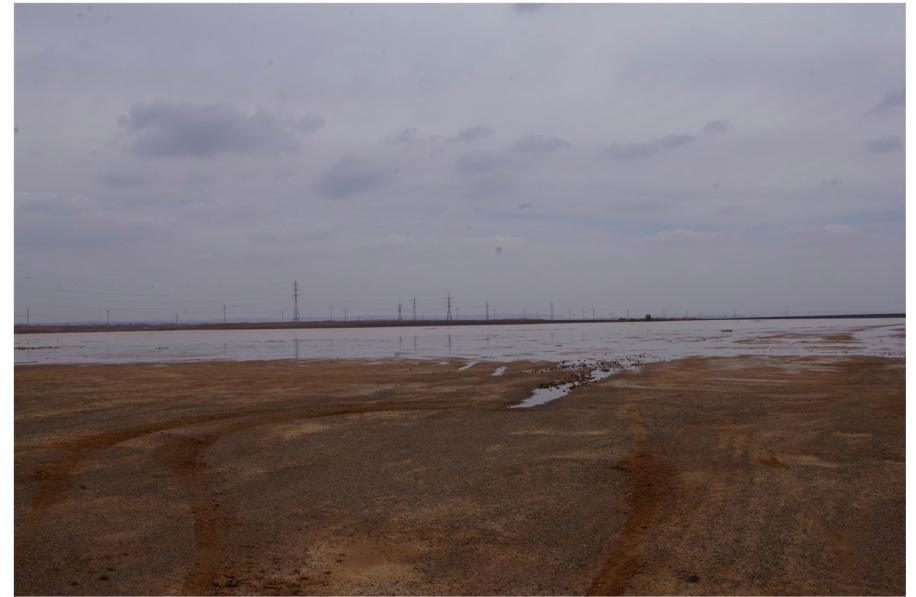
Figure 3. Shizafon Playa (Qa Shizafon) under inundation. The picture was taken on 14 April 2017, one day after a heavy rainstorm, by Ilan